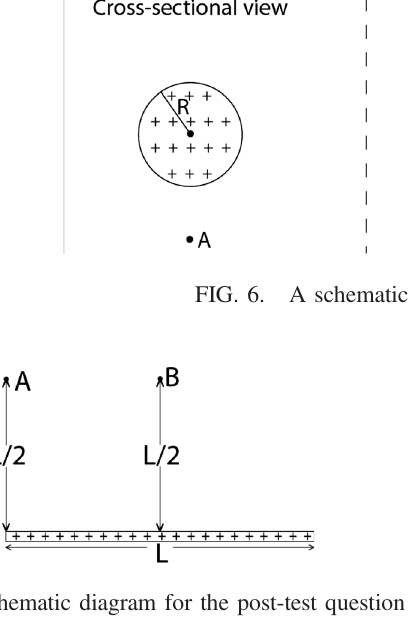
Fig. 5, each at a distance L above a finite uniform line of positive charge of length 2 L . Draw arrows to show the direction of the net electric field at each of these three points. Explain. (2) Consider the three points A 0 , B 0 , and C 0 shown in Fig. 5, each at a distance L= 2 above the finite uniform line of charge. Draw arrows to show the direction of the net electric field at each of these three points. Explain how the direction at point A compares with A 0 and the direction at point B compares with B 0 .